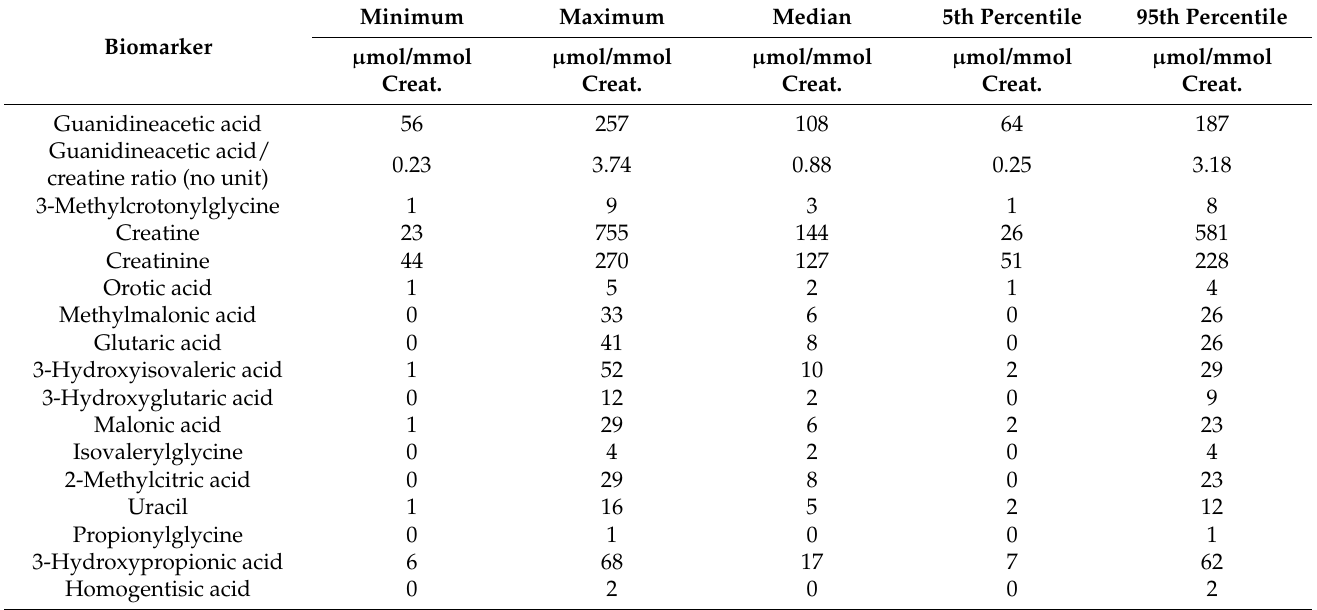
Table 6. Reference intervals (5th–95th percentiles) established for each biomarker analyzed as part of the organic acids second-tier test, following the analysis of 50 urine samples from 21-day old babies. Extreme outliers (>3 interquartile ranges from the 75th percentile) were excluded from the statistics. Minimum, maximum, and median values are also